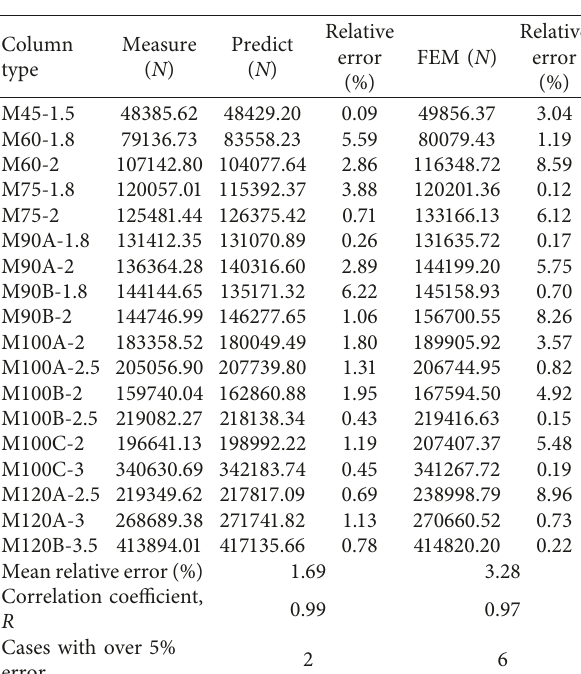
Figure 16: Confidence intervals of the ultimate load. Table 5: Comparison among the real measured values, predicted values, and finite element numerical values.